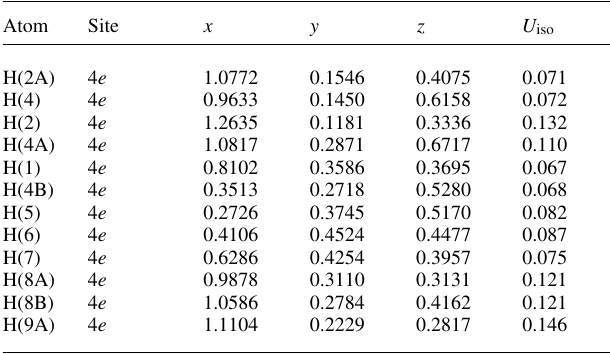
Table 2. Atomic coordinates and displacement parameters (in Å 2 )